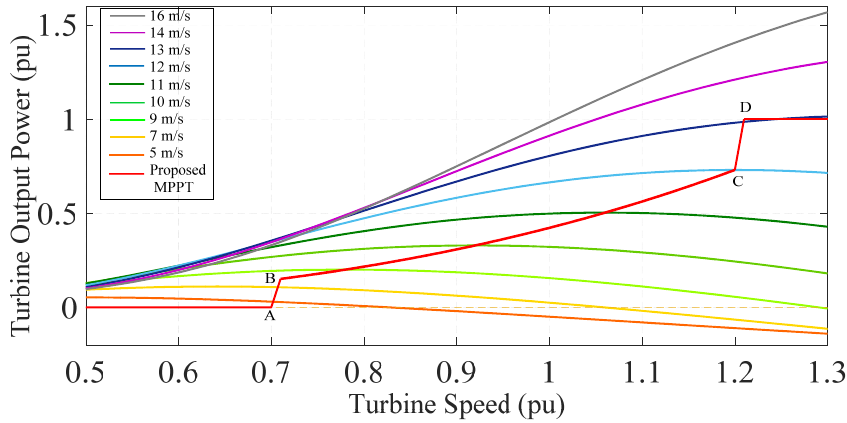
Figure 11. Proposed MPPT for different wind speeds.